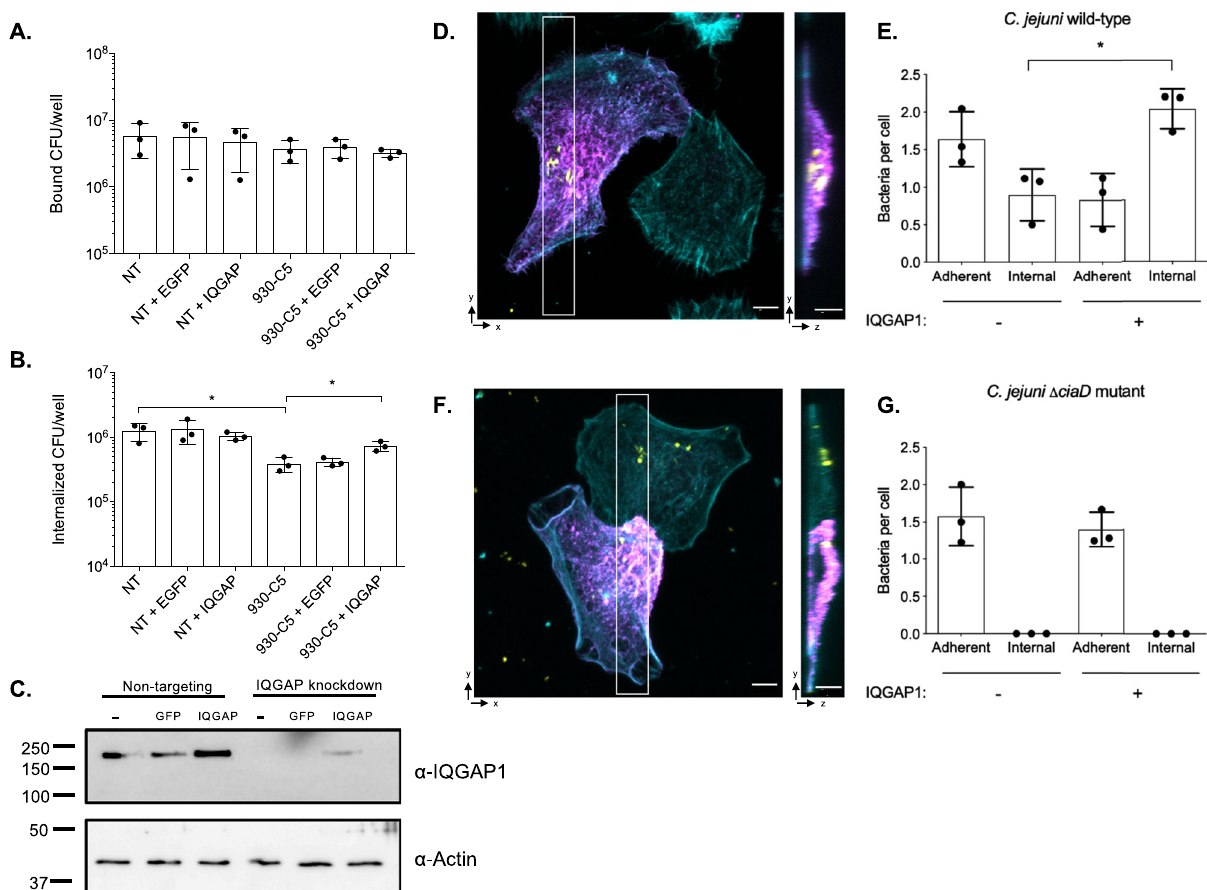
Fig. 3 IQGAP1 is required for cellular invasion by C. jejuni . Stable INT 407 cell lines expressing a non-targeting (NT) shRNA or an IQGAP1-targeting shRNA (930-C5) were generated. Rescue experiments were performed by transfecting the stable clones with the pCMV-EGFP-Myc (EGFP) or pCMV- IQGAP1-Myc (IQGAP1) plasmids. Cellular adherence and internalization of the C. jejuni wild-type strain were measured. A Knockdown or rescue of IQGAP1 does not alter the cellular adherence of C. jejuni to any of the cell types tested ( n = 3 independent samples). B Knockdown of IQGAP1 reduces C. jejuni internalization while expressing IQGAP1-Myc improves invasion. In panels A and B , error bars represent the standard deviation; differences were compared using an ANOVA on log-transformed counts followed by a two-tailed Sidak ’ s test (* p < 0.05) ( n = 3 independent samples). Comparing NT to 930-C5, p = 0.0007. Comparing 930-C5 to 930-C5 + IQGAP1, p = 0.0472. C The amount of IQGAP1 in the cell lines was determined by immunoblot. Actin was used as a loading control for the cell lysates. Molecular weights are indicated in kDa. D To test if the mosaic nature of transient transfection was responsible for the incomplete restoration of invasion in the IQGAP1 knockdown cells that were transfected with IQGAP1, we used microscopy to assess the internalization of C. jejuni into cells. IQGAP1 knockdown cells were transfected with pCMV-IQGAP1-Myc, infected with C. jejuni for 10 h, then fi xed and stained for C. jejuni (yellow), actin (cyan), and with an anti- Myc antibody (magenta). A z-section was constructed from the section in the white box (right). From the z- section, it is apparent that the C. jejuni associated with the cells expressing IQGAP1 are internalized. E Three biological replicates were imaged, and more than 15 cells were analyzed for each condition (IQGAP1 expressing and non-expressing). We found that the number of internalized C. jejuni was higher in the cells expressing IQGAP1. White bars represent 5 µ m. Comparing internalized bacteria in IQGAP1 negative to IQGAP1-positive cells, p = 0.0061. F Cells were infected with a C. jejuni Δ ciaD mutant and imaged. From the z-section, it is clear that the C. jejuni Δ ciaD mutant does not invade cells, regardless of whether IQGAP1 is present. White bars represent 5 µ m. G From three biological replicates, greater than 15 cells were analyzed, and the number of internal and external C. jejuni were determined. No internalized bacteria were observed in cells infected with the C. jejuni Δ ciaD mutant. In panels E and G , each dot represents a biological replicate, the column represents the mean, error bars represent standard deviation, and signi fi cant differences were assessed using a two-tailed Student ’ s t -test (* p <